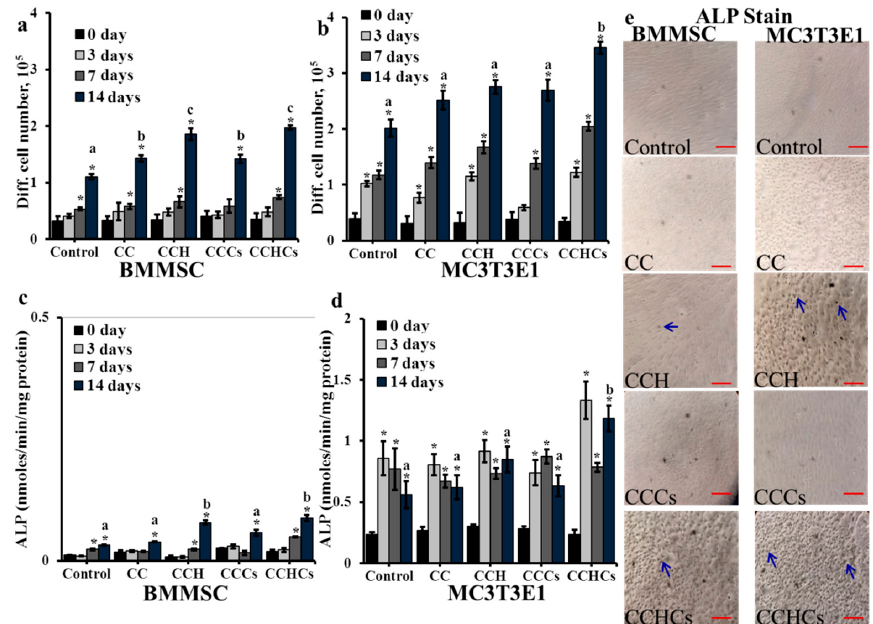
Figure 3. The e ff ect of chitosan-collagen-based bio-mimic 3D matrices on bone cells’ di ff erentiation ( a , b ), cellular alkaline phosphatase (ALP) ( c , d ) (Supplementary Figure S1 shows the level of ALP normalized with the cell number), and histological staining of alkaline phosphatase ( e ) using naphthol AS-MX phosphate and fast blue RR dye; cells were stained with naphthol AS-MX phosphate and fast blue RR after 14 days of culture and arrows show positively-stained cells. Scale bars: 40 µ m. BMMSC: bone marrow-derived mesenchymal stem cells. CC: chitosan-collagen 3D matrix, CCH: chitosan-collagen-hydroxyapatite 3D matrix, CCCs: chitosan-collagen-chondroitin sulfate 3D matrix, and CCHCs: chitosan-collagen-hydroxyapatite-chondroitin sulfate 3D matrix. The experiments were done three (a–d) or two (e) times with similar results. * p < 0.05 vs. zero days; di ff erent letters indicate statistical significance among 3D matrices for 14